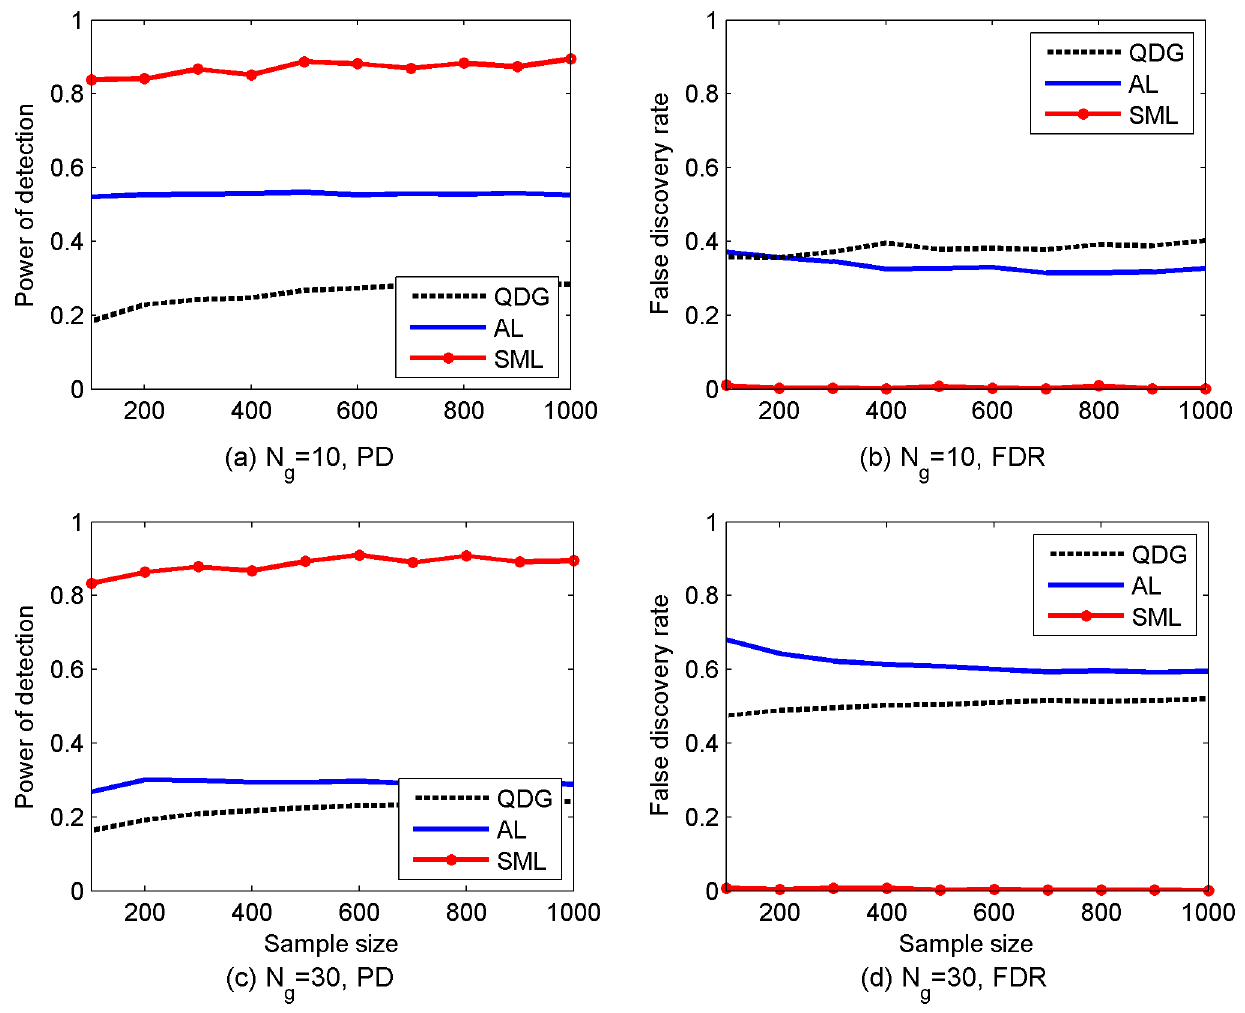
Figure 3. Performance of SML, AL and QDG algorithms for directed cyclic networks of N g ~ 10 [(a) and (b)] or 30 [(c) and (d)] genes. Expected number of nodes per node is N e ~ 3 . PD and FDR were obtained from 100 replicates of the network with different sample sizes ( N ~ 100 to 1,000).